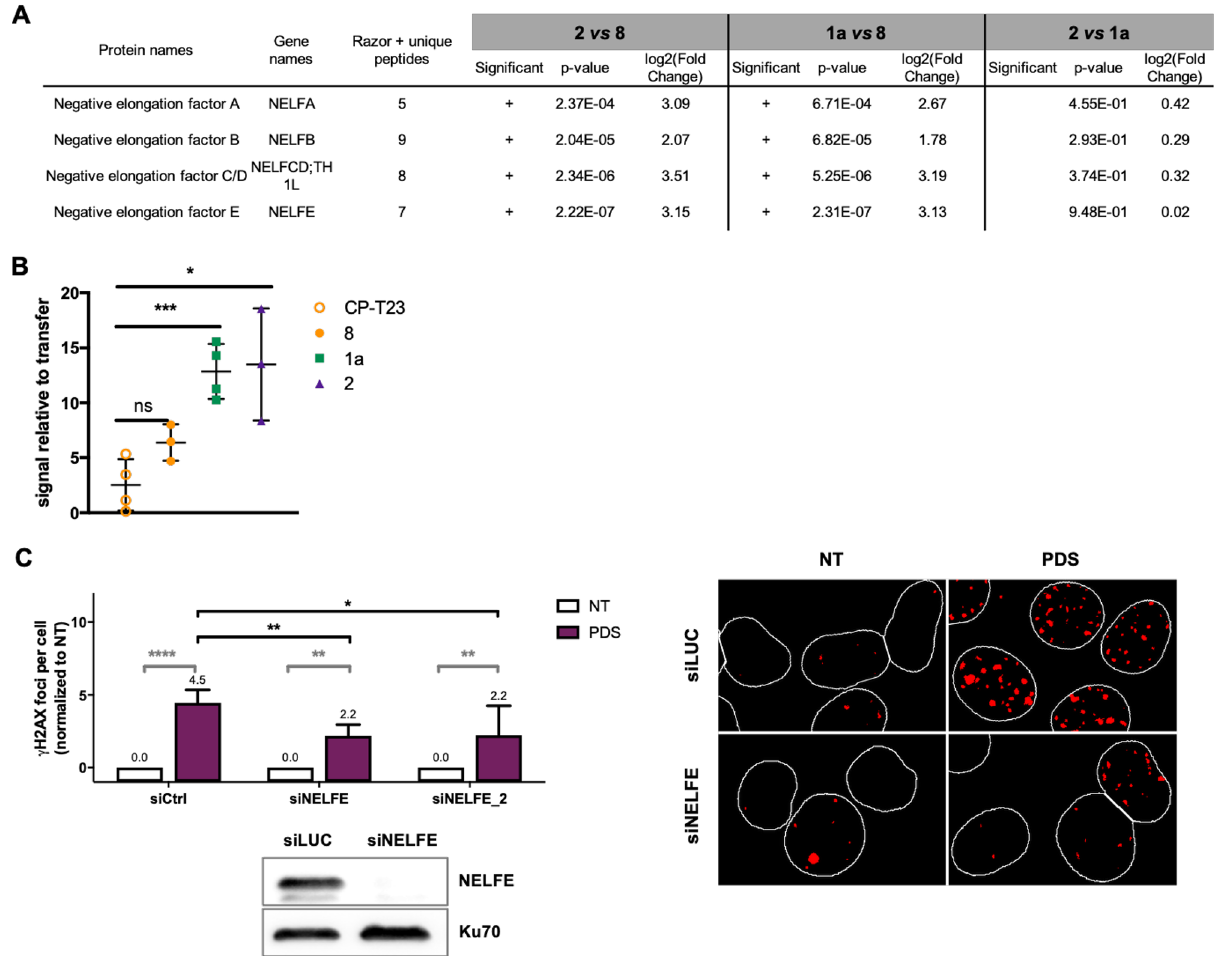
Figure 6. NELF complex interact with G4 structures and modulates the cellular response to G4 ligands. ( A ) MS-based quantitative proteomic analysis of the interaction of the NELF-complex proteins with contrained-G4 structures (extracted from Supplementary Table 1). Differentially interacting proteins were sorted out using a fold change ≥ 2 and p -value < 0.05, allowing to reach a false discovery rate (FDR) inferior to 5% according to the Benjamini–Hochberg procedure. ( B ) Quantification of the interaction of immunoprecipitated Flag NELF-E protein with constrained G4 structures ( 1a , 2 ) relative to cyclopeptide (CP-T23) and duplex control ( 8 ) constructions. Error bars represent SD from the means, n ≥ 3 independent experiments. p values were calculated using unpaired t-tests (without corrections for multiple comparisons). ns: p > 0.05; *: p < 0.05; **: p < 0.01; ***: p < 0.001; ****: p < 0.0001. ns non-significant difference. ( C ) Quantification and representative images γH2AX foci fluorescence signal (red) detected HeLa cells transfected with control (Ctrl), or two NELF-E siRNAs (independent sequences) and treated with PDS (20 µM) for 4 h. Error bars represent SD from the means, n ≥ 3 independent experiments. p values were calculated using an unpaired multiple Student’s t test. ns: p > 0.05; *: p < 0.05; **: p < 0.01; ***: p < 0.001; ****: p < 0.0001signals. Western-blotting analysis of NELF-E depletion in HeLa cells following siRNA treatment is